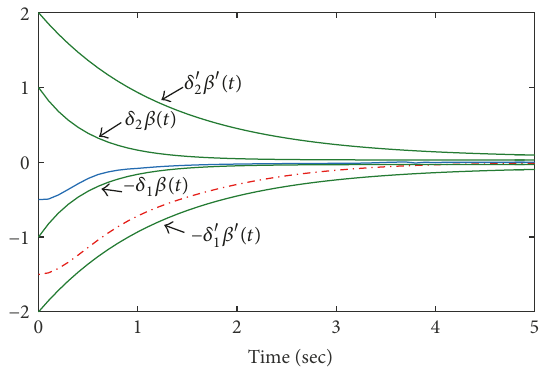
Figure 11: Tracking error: 𝑒 (-) and 𝑒 󸀠 (-.-).